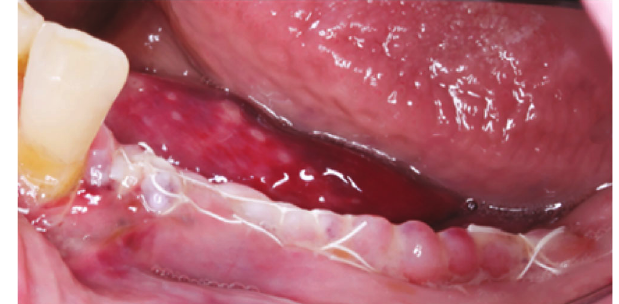
Figure 14: Day 1 after surgery.